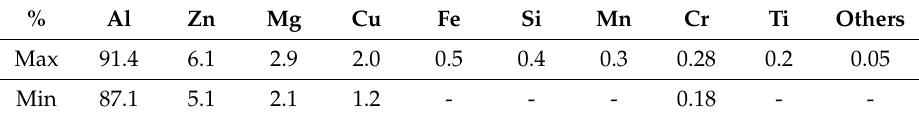
Table 1. Chemical composition for the Al 7075-T651 alloy, data from [1].